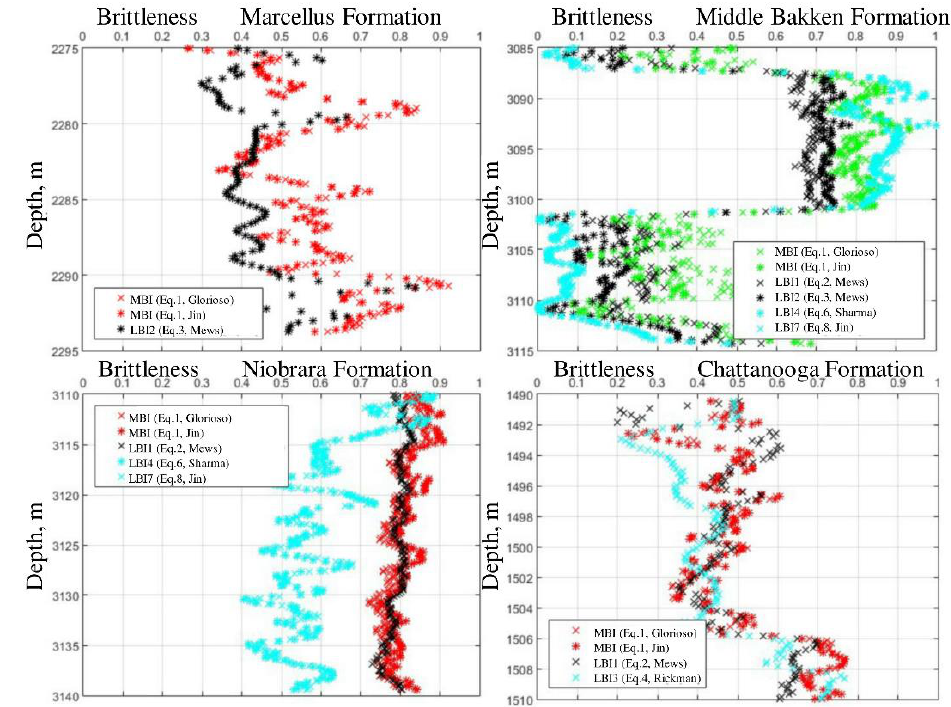
Figure 2. Brittleness evaluation from different correlations for four formations. Modified after Mews et al., 2019 [4].